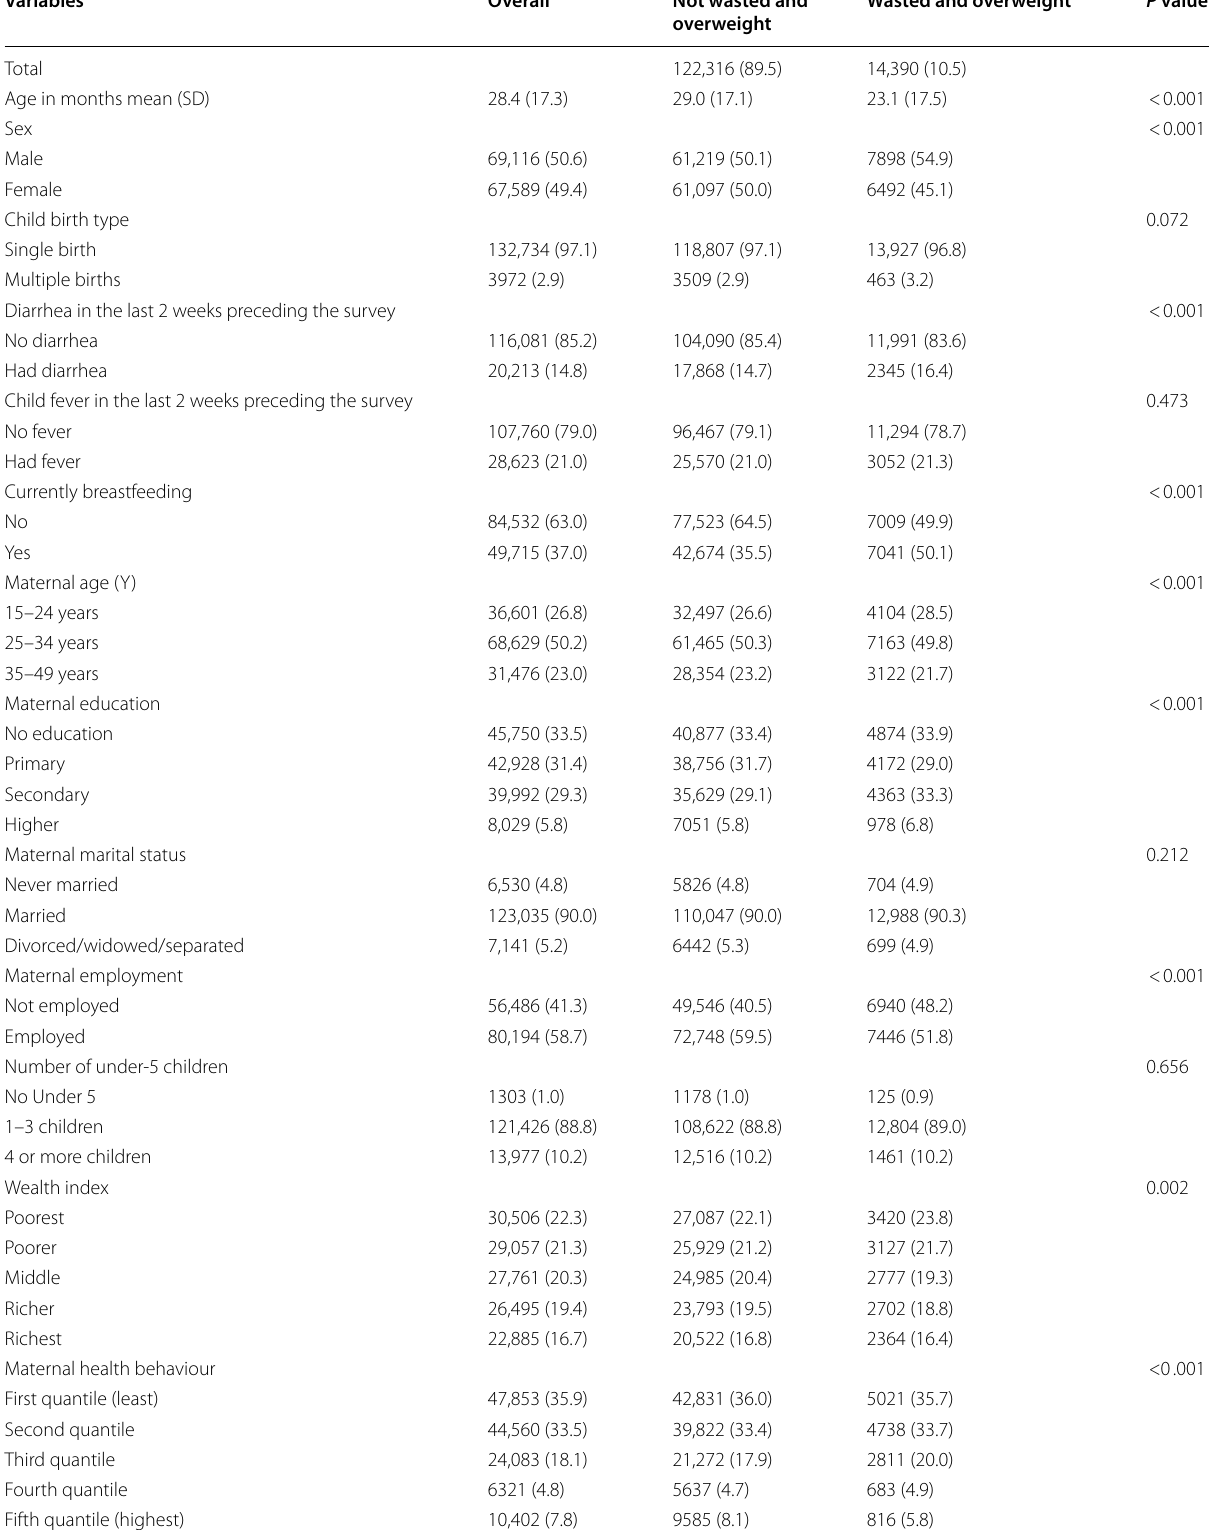
Table 2 Summary of the 27 countries pooled sample characteristics of DHS data